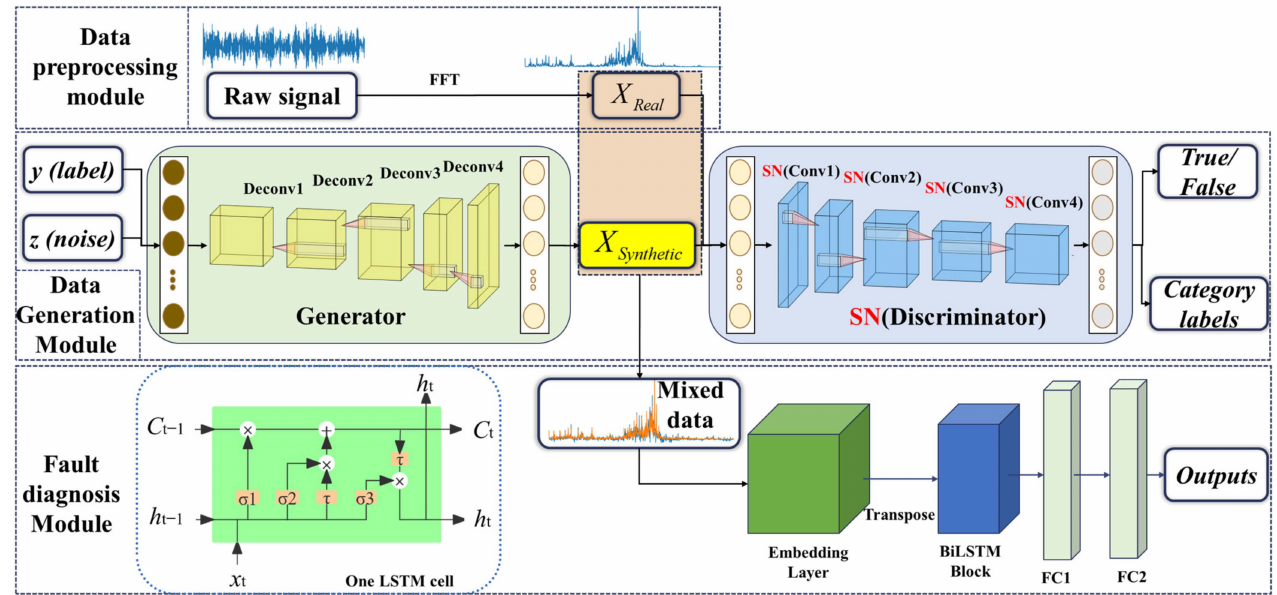
Figure 2. The framework of our proposed ACGAN-SN model for fault diagnosis with S & I